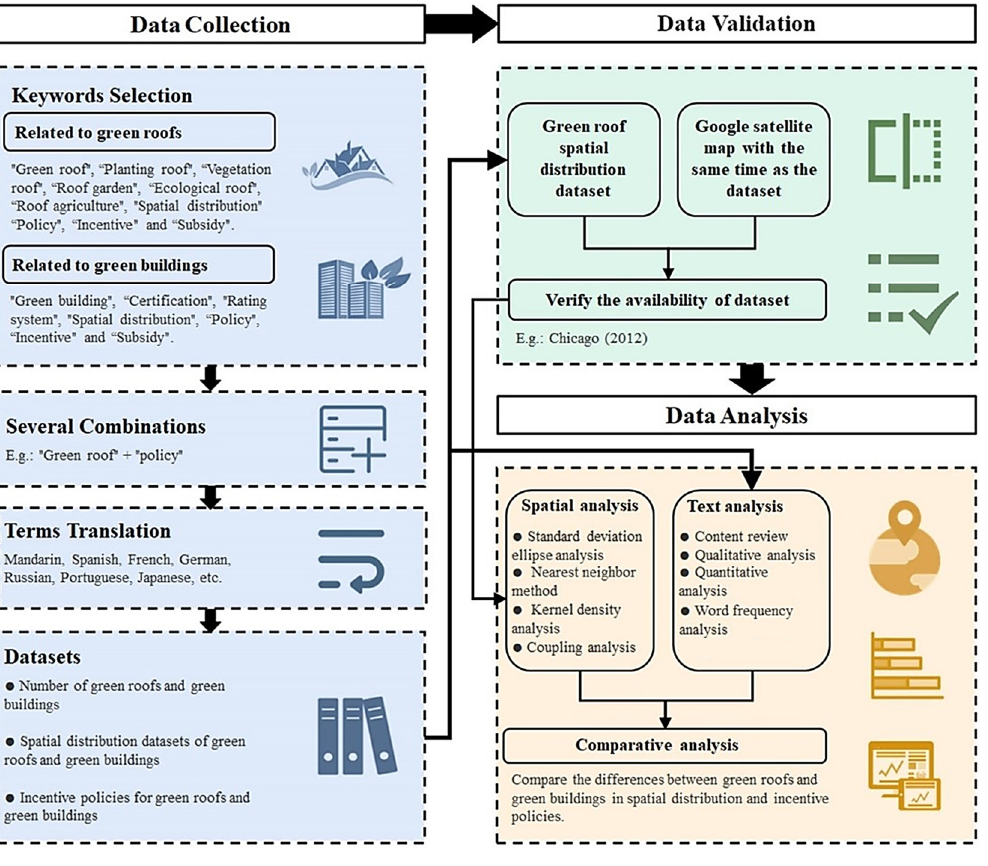
Figure 1. The flowchart of this study.